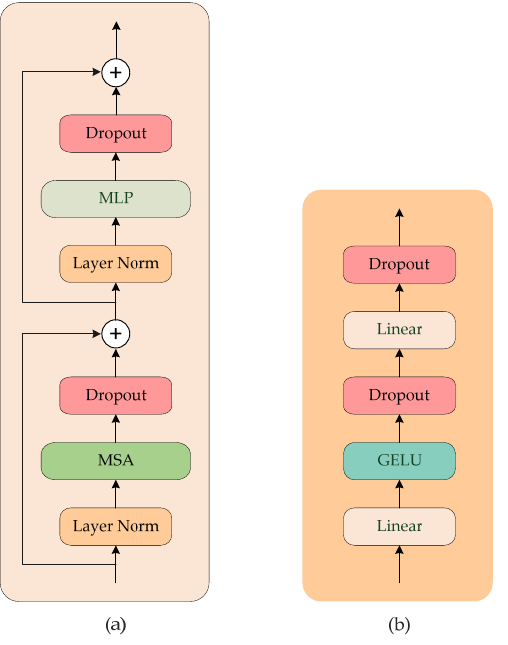
Figure 3. Transformer encoder and MLP Block. ( a ) Transformer encoder; ( b ) MLP Block. Self-attention can model the long-term dependencies in the input sequence data, and self-attention is calculated as shown in Equations (3) and (4). Q , K , and V represent query, key, and value matrices, respectively, and value represents the extracted information. The query is matched with the key by calculating the correlation between them, and the calculation process is the softmax part in Equation (3) with dk as the length of vector k . The final multiplication with V indicates that greater correlation corresponds to the greater weight of the vector in V .